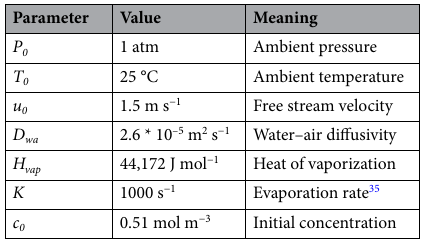
Table 1. Initial values and some parameters setting for